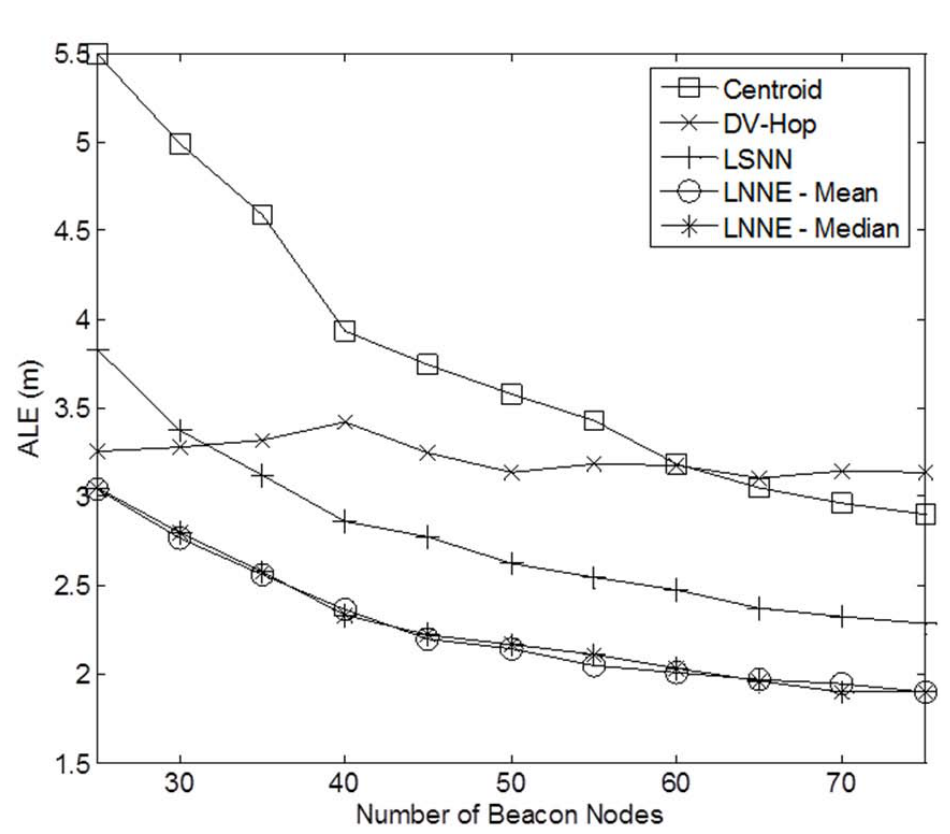
Performance comparison among different beacon ratios ( N = 250, beacon ratio = 0.1–0.3, no coverage